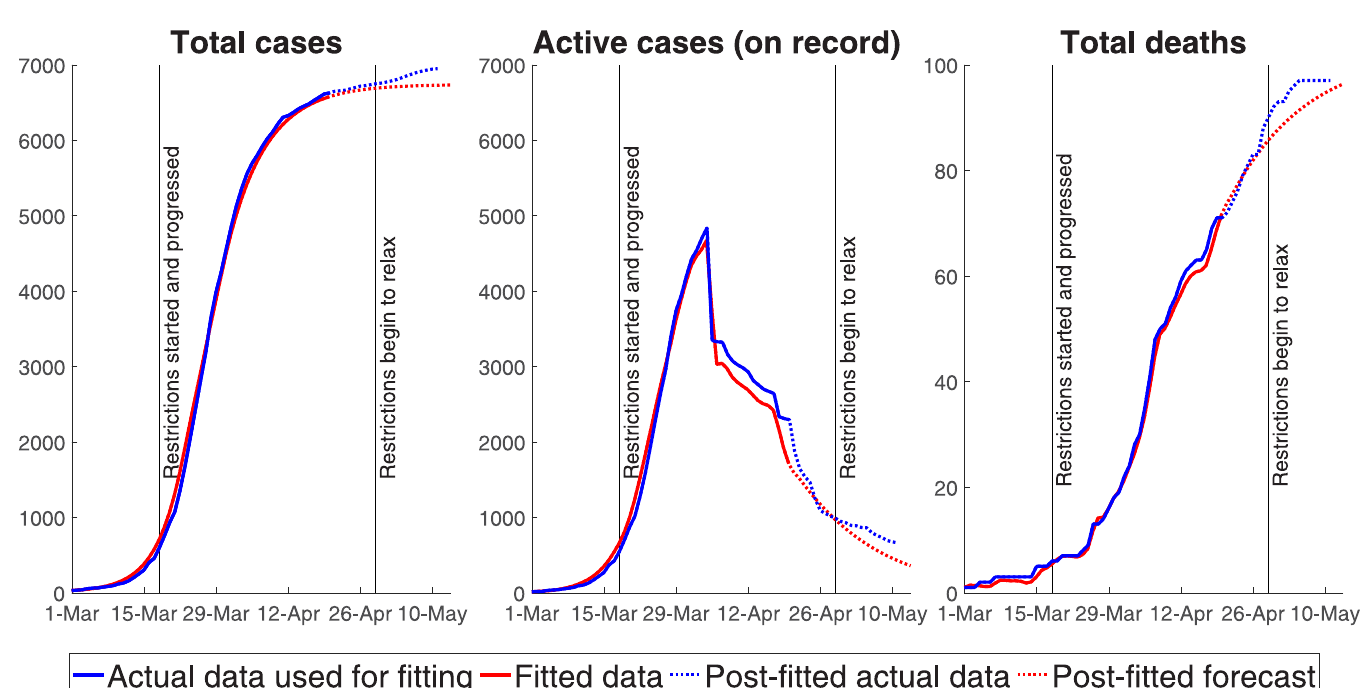
Fig 3. Projected versus actual